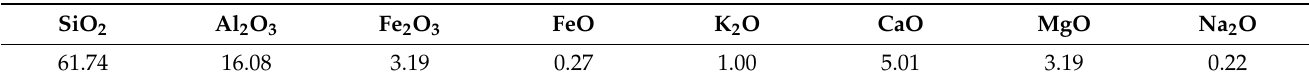
Table 4. Chemical composition of